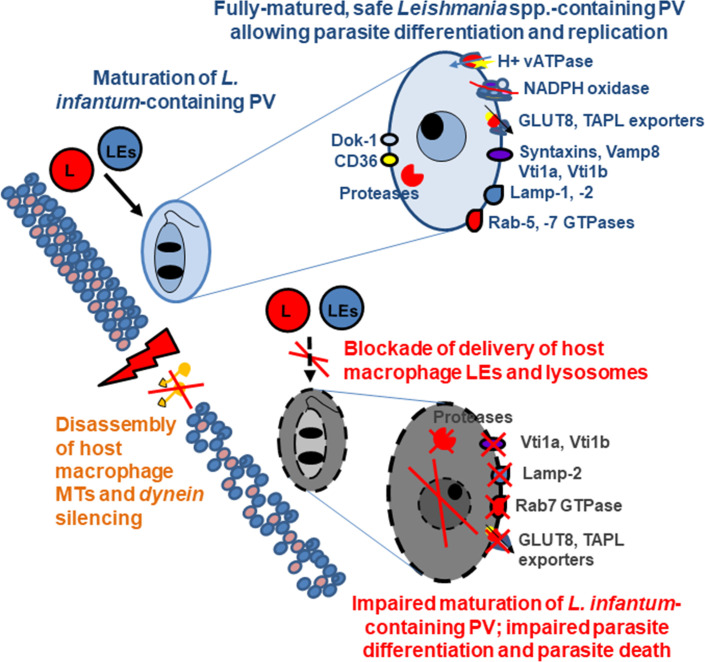
Scheme summarizing the abolition of maturation of tight-fitting L. infantum-containing PVs by structurally and functionally altering the MT network of macrophage-like cells.Such alteration of the MT network results in most of the phagocytosed L. infantum promastigotes remaining permanently insulated in non-mature phagosomes, in which they do not undergo normal promastigote-to-amastigote differentiation and finally die.